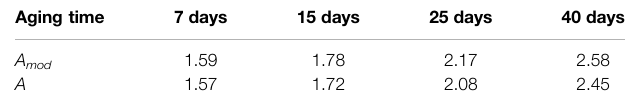
TABLE 5 | A mod and A of non-uniform samples.